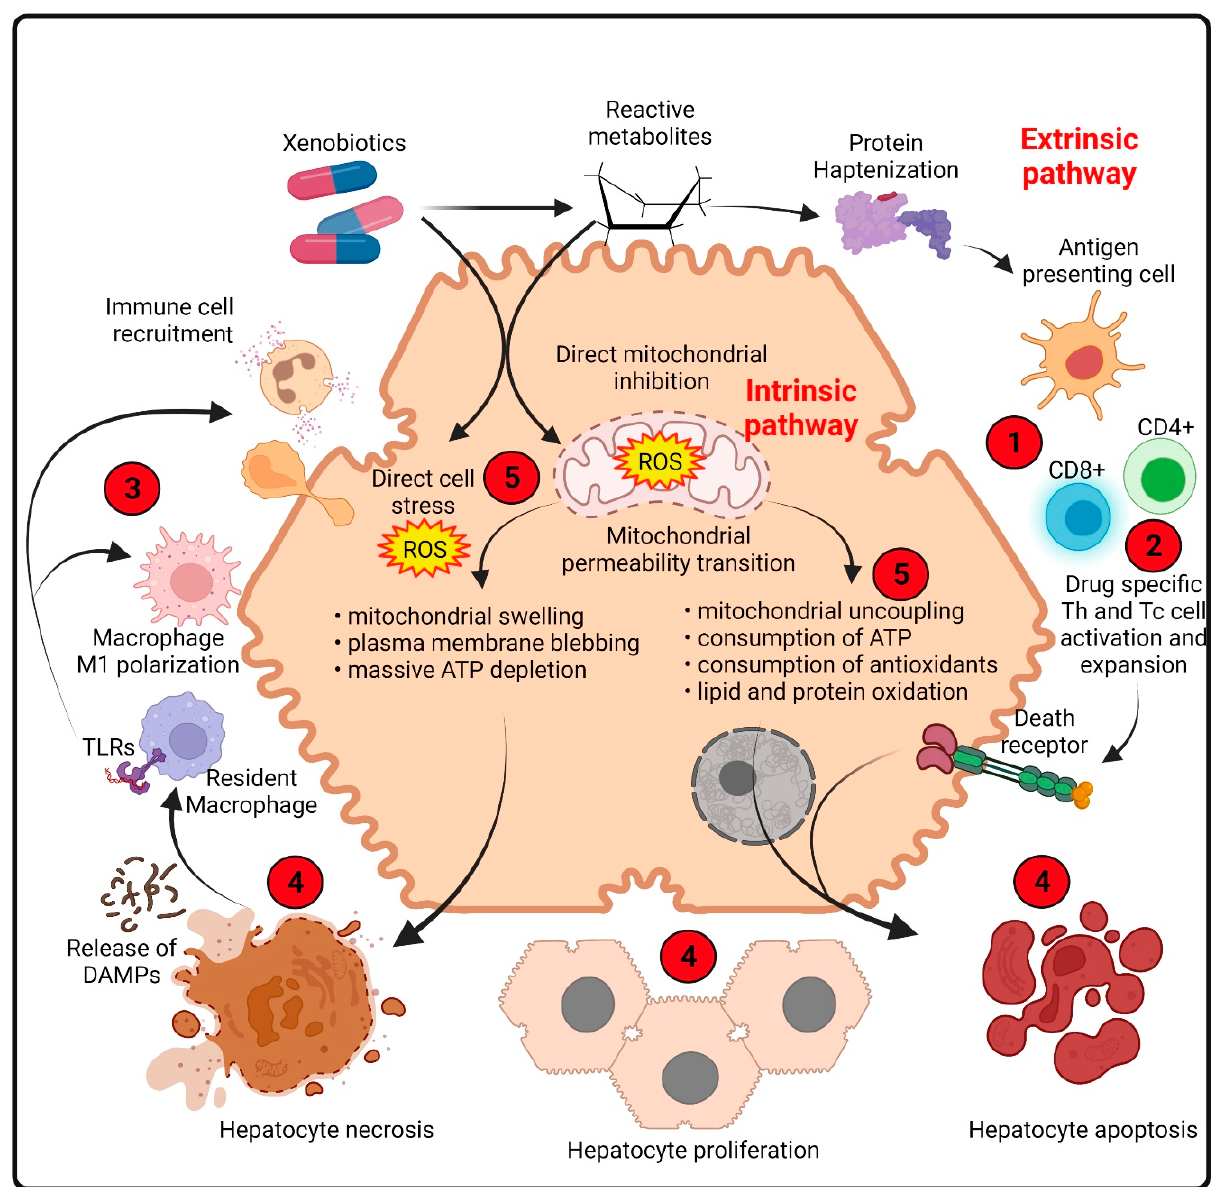
Figure 1. Pathogenesis of drug-induced liver injury. The normal hepatocyte shown in the center of the figure may be affected in multiple ways, including mitochondrial impairment [9], reactive metabolites that induce chemical and oxidative stress and protein modifications (both by intrinsic pathways) and innate and adaptive immune responses (extrinsic pathways) [18]. The impairment of the energetic and redox balance finally triggers apoptotic or necrotic processes according to poor or insufficient ATP levels [19]. Drugs are relatively small molecules and, therefore, are unlikely to evoke an immune response. However, they can act as haptens and bind covalently to proteins [20]. The resulting adducts are taken up by antigen-presenting cells (APCs) and processed into peptides, which are then presented to CD8+ and CD4+ cells in association with MHC class I or II molecules, respectively [21]. Apoptosis occurs in concert with immune-mediated injury, destroying hepatocytes by way of the activation of the tumor necrosis factor-alpha (TNF- α ) receptor and Fas pathways, with cell shrinkage and fragmentation of nuclear chromatin [19]. The red circles indicate the DILI pathological events that may be moderated by the administration of MSCs (see Figure 2). DAMPs: damage-associated molecular patterns; ROS: reactive oxygen species; TLRs: toll-like receptors. Created with BioRender.com; accessed on 23 February